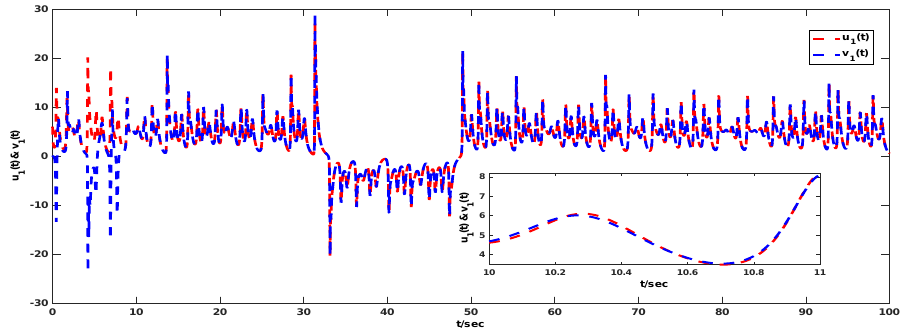
Figure 12. Synchronized time response of the states ( t , u 1 ( t )) and ( t , v 1 ( t )) of the drive-response systems (13) and (14) with fractional order q =